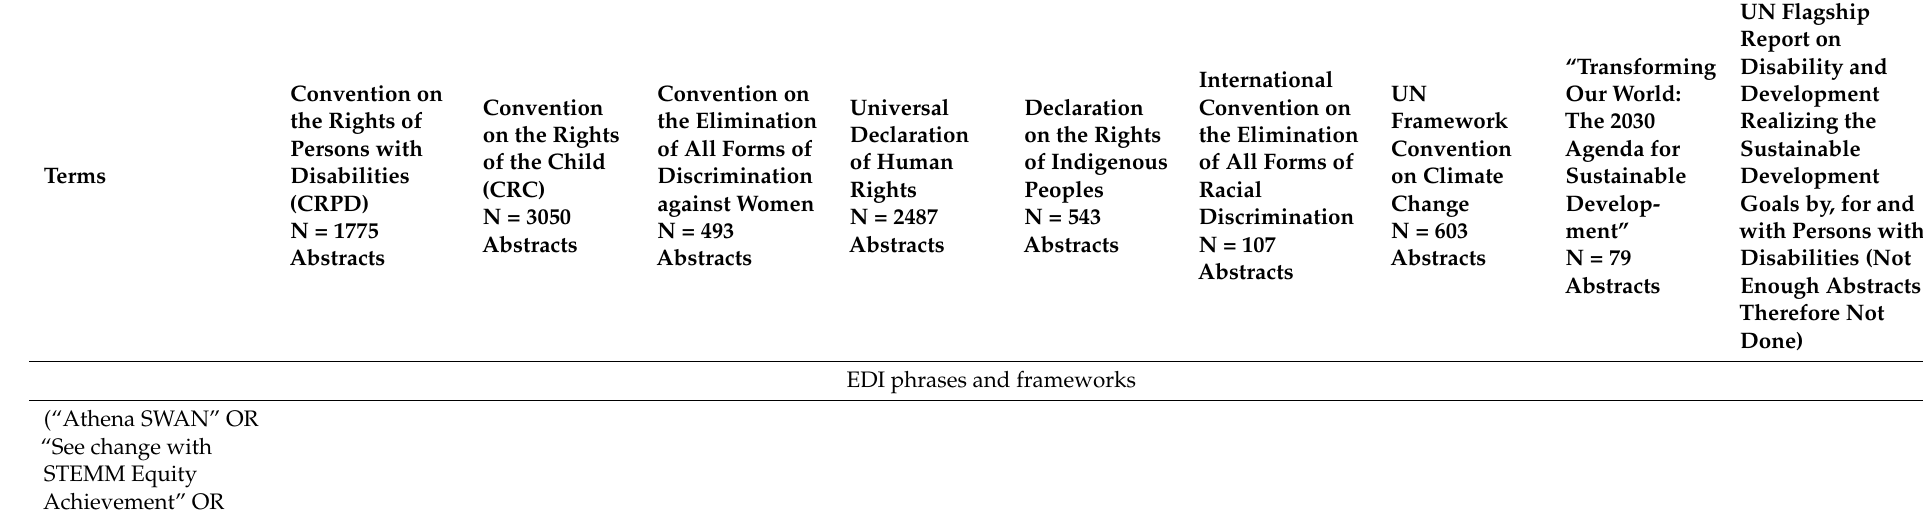
Table 18. Presence of EDI phrases and frameworks and marginalized groups covered within EDI in abstracts mentioning “the